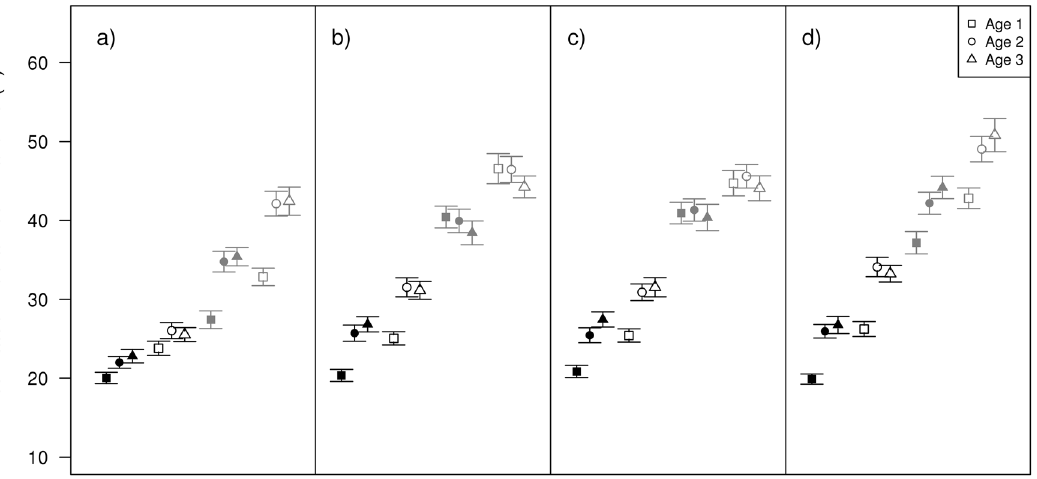
Figure 10. Expected survival and sex after infection. Expected median survival time according to species, sex, infection treatment and age. Black symbols=males, gray symbols=females. Filled symbols=parasite-increased, empty symbols=parasite-control. Error bars show 95% confidence intervals. a) Argia anceps , b) A. extranea , c) Hetaerina americana and d) Protoneura cara .